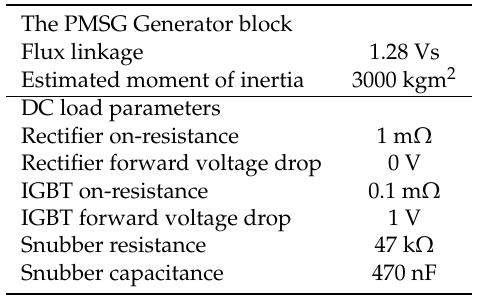
Figure 3. The Simulink model with the block Vortex simulation that imports the vortex code as a function. The DC load with rectifier block has been replaced with three resistors for the AC-load simulations. Table 2. Rectifier and DC load parameters in